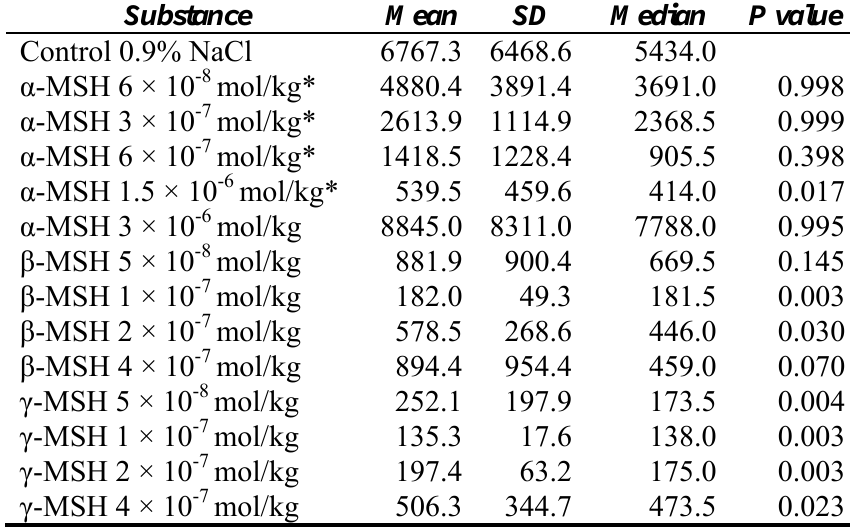
Table 2. Aspartate aminotransferase activity (U/L) in plasma 24 h after acetaminophen administration (150 mg/kg i.g.). Tested substances were given intraperitoneally 1 h